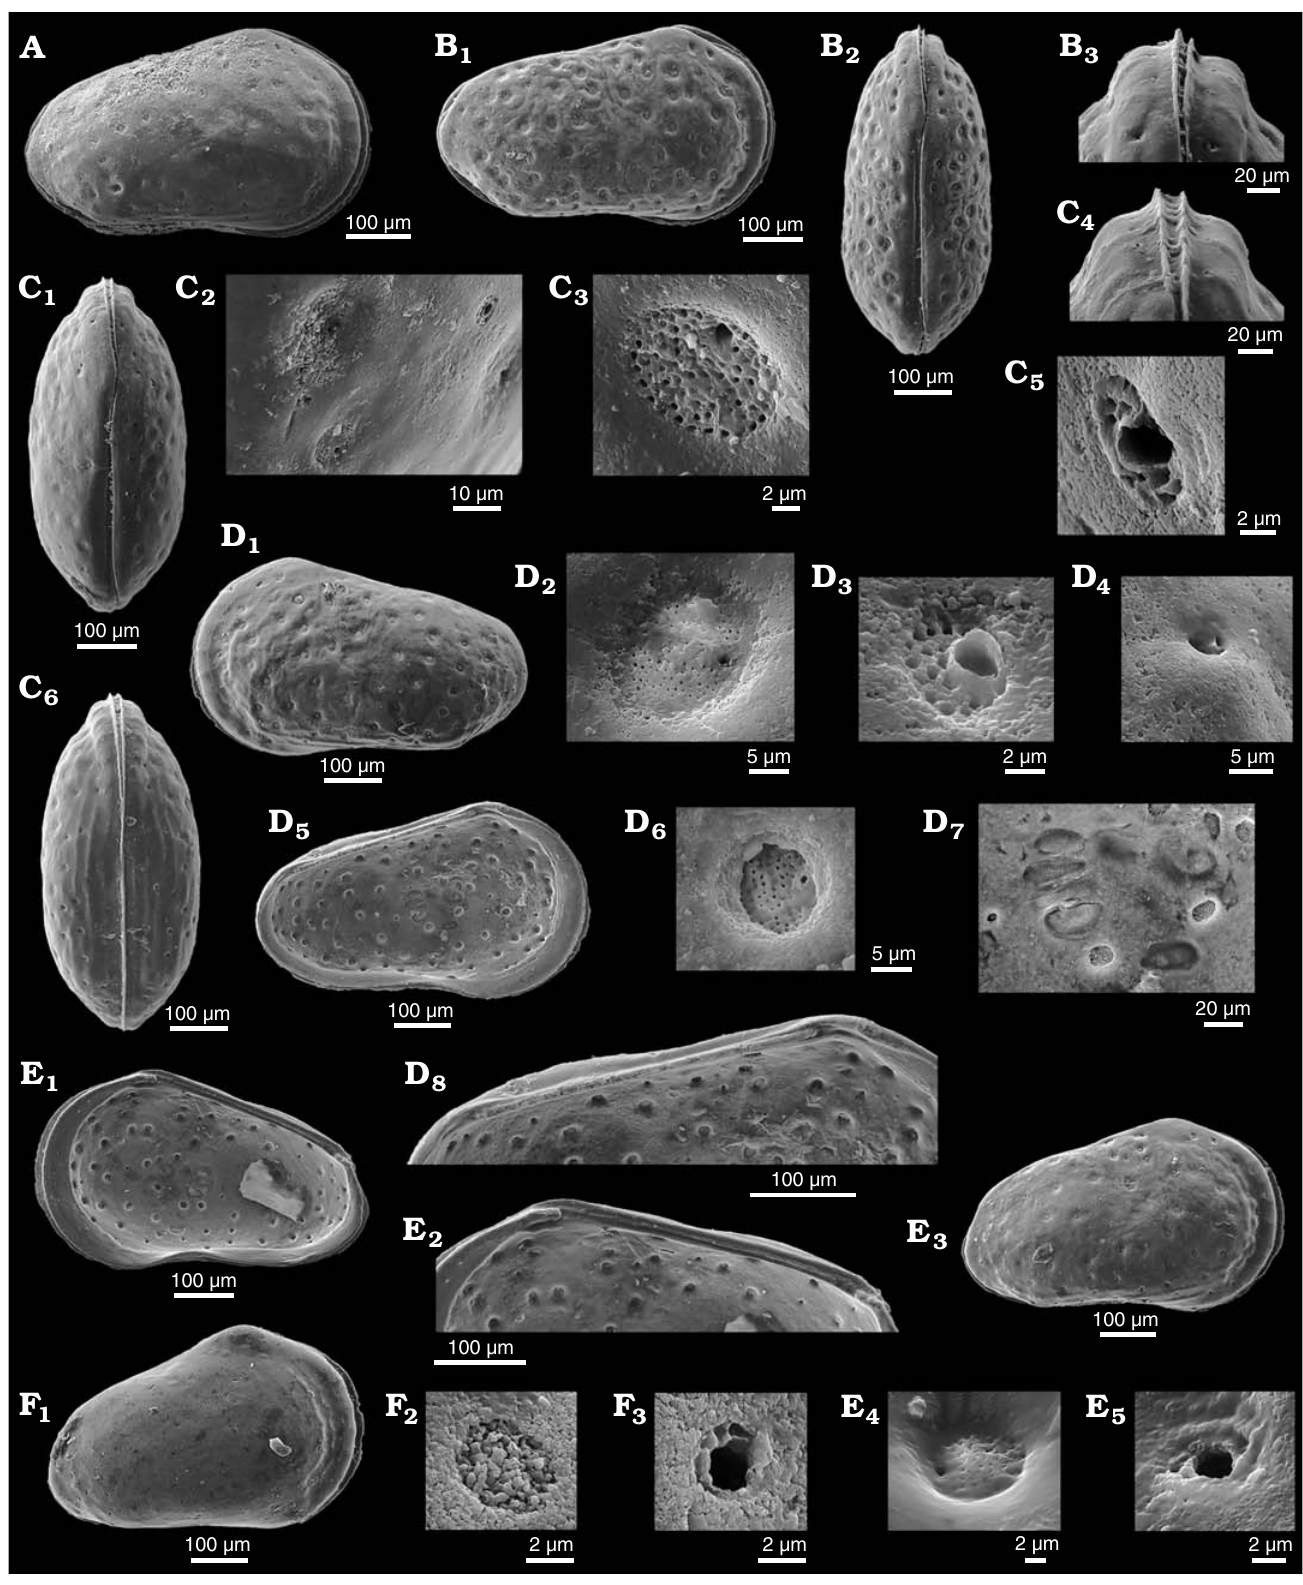
Fig. 7. Cytherid ostracod Minyocythere macroporosa sp. nov. from Borehole Hambühren WA2, 166–167 m (A–C), 166 m (D, E), 168–169 m (F), NW Germany, Witchellia laeviuscula Zone (Braun Jura γ ), Lower Bajocian. A . Paratype, SMF Xe 23718, female carapace in right view. B . Paratype, SMF Xe 23719, male carapace in right (B 1 ) and dorsal (B 2 ) views, antero-dorsal margin (B 3 ). C . Paratype, SMF Xe 23720, female carapace in dorsal (C 1 ) and ventral (C 6 ) views, pores (large and small) (C 2 ), macro sieve-type normal pore canals (StPC-M) (C 3 ), antero-dorsal margin (C 4 ), and micro sieve-type